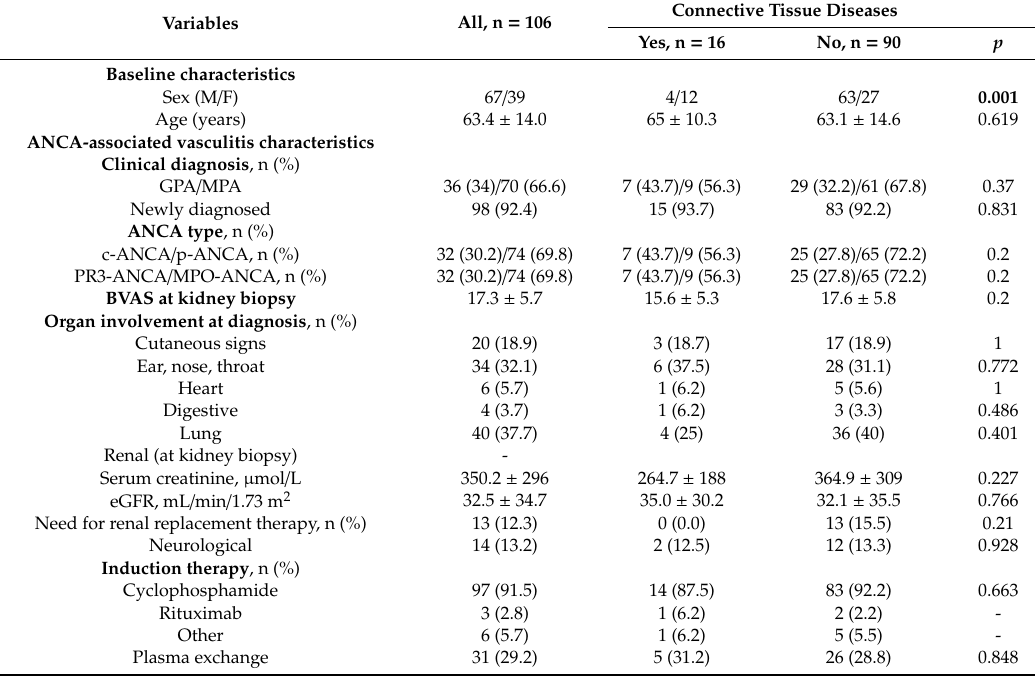
Table 2. Baseline characteristics of AAV patients according to presence or absence of CTD. Significant p values appear in bold.